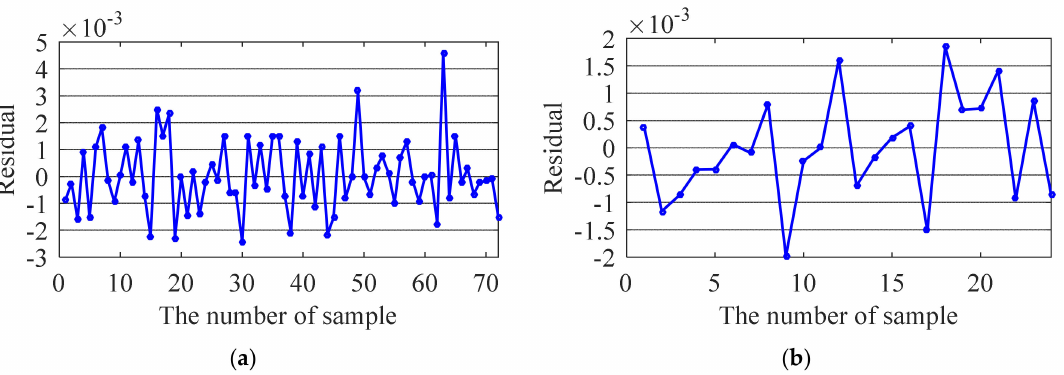
Figure 15. Residual of the second modal frequency: ( a ) Training sample; ( b ) Testing sample.